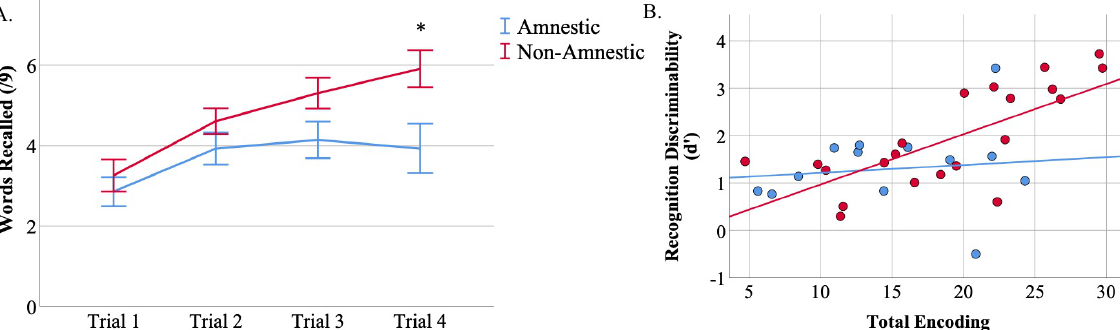
Figure 2. Total encoding is related to d’ in non-amnestic AD. ( A ) The non-amnestic group demon- strated poor Trial 1 learning comparable to the amnestic group. However, the non-amnestic group benefitted from repetition of the word list while the amnestic group demonstrated a flat learning curve. * p < 0.05. ( B ) Total encoding performance (sum of Trials 1 through 4) is related to recognition discriminability (d’) in the non-amnestic group (r = 0.72, p = 0.0002) but not the amnestic group ( p =